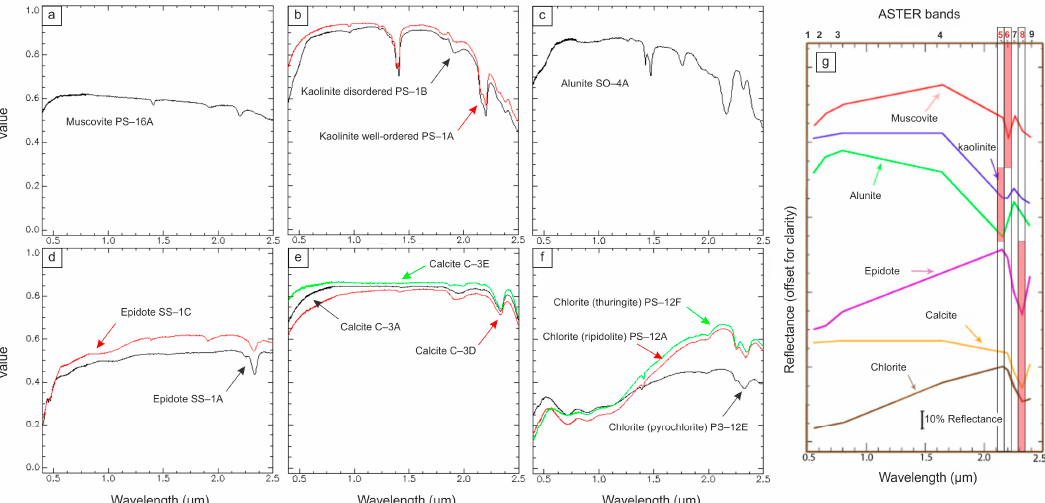
Figure 4. ( a – f ) Spectral signatures of muscovite, kaolinite, alunite, epidote, calcite, chlorite from